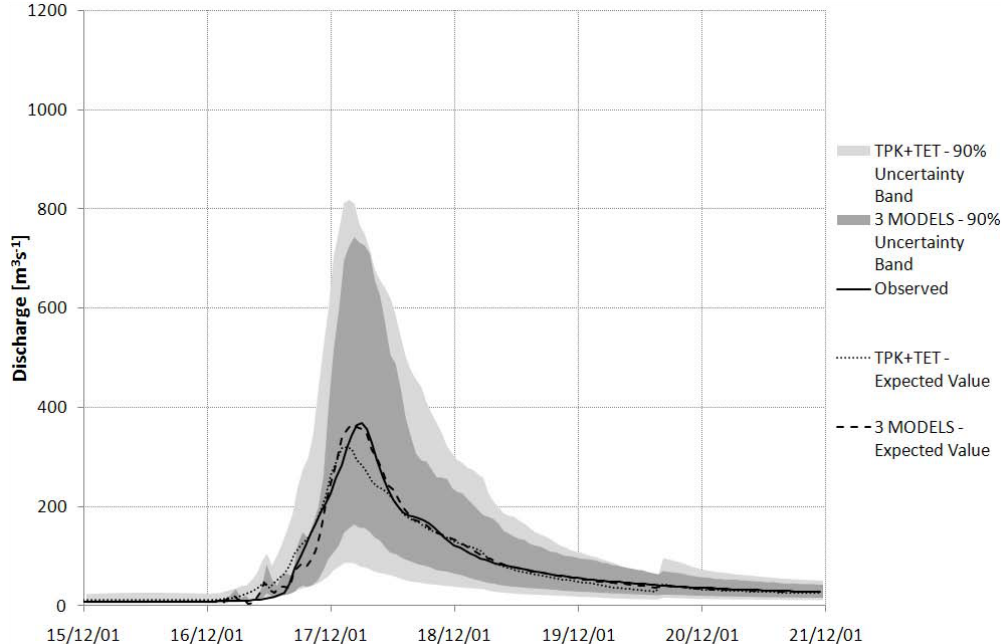
Fig. 14. Comparison between the PU computed combining, two or three models on a flood event for the calibration period. Observed discharges (black line); expected value conditioned only to the TOPKAPI and TETIS forecasts (dotted line); expected value conditioned to the TOPKAPI, TETIS and ANN forecasts (dashed line); 90% uncertainty band conditioned to the TOPKAPI and TETIS forecasts (light grey band); 90% uncertainty band conditioned to the TOPKAPI, TETIS and ANN forecasts (grey band).